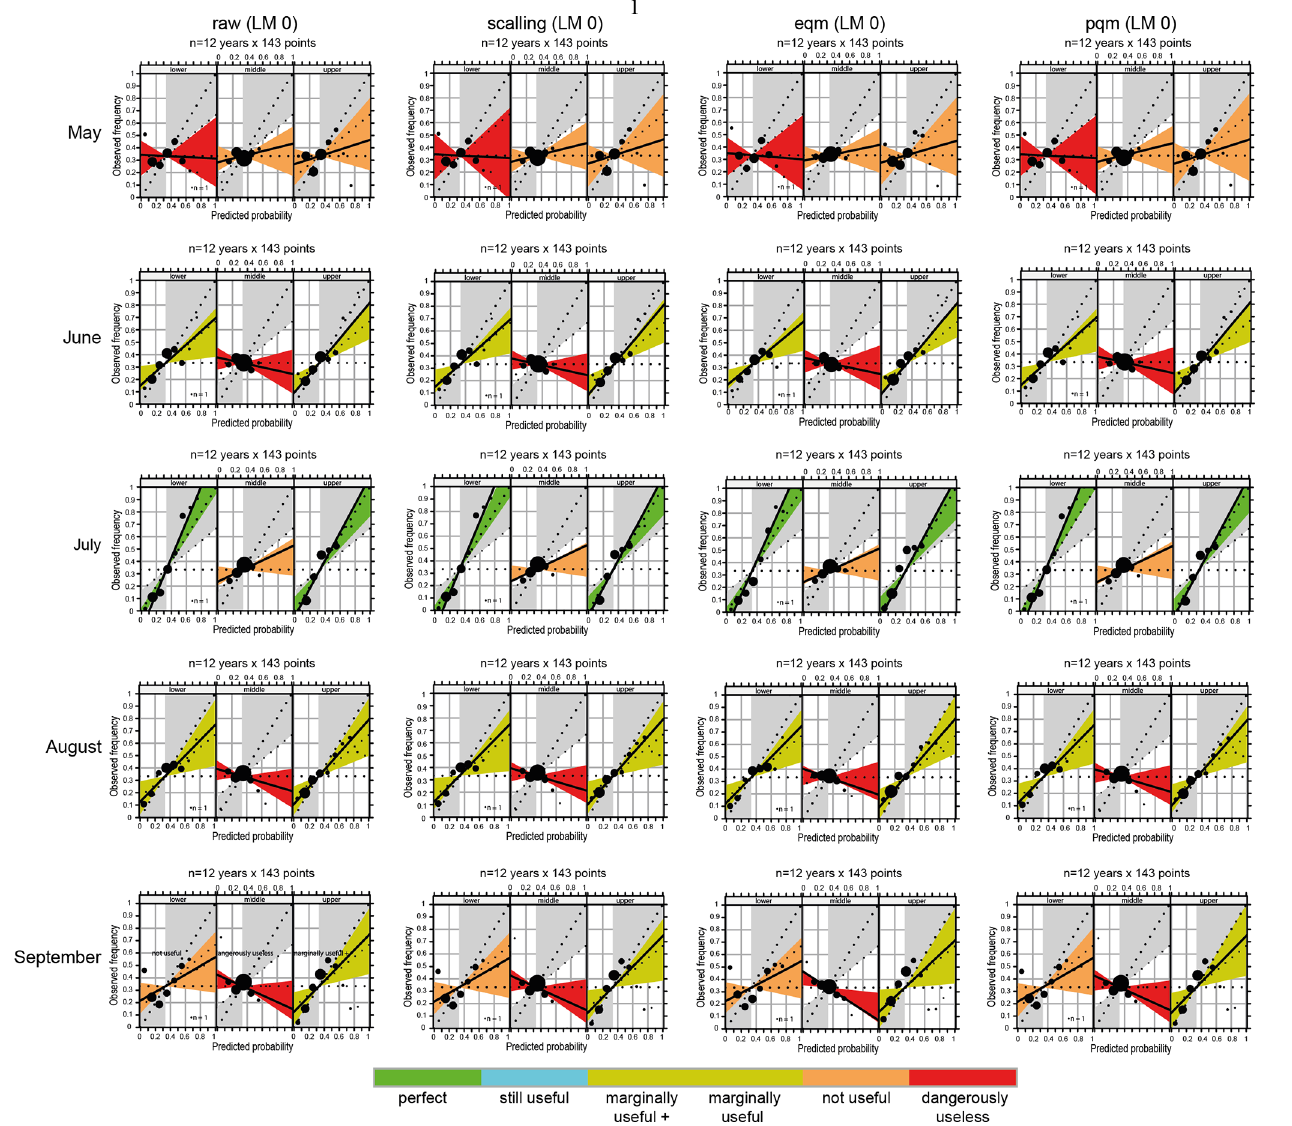
Figure 3. Reliability diagrams of tercile precipitation forecasts with lead month 0 for May–September obtained for SEAS5 raw model data and the bias correction methods